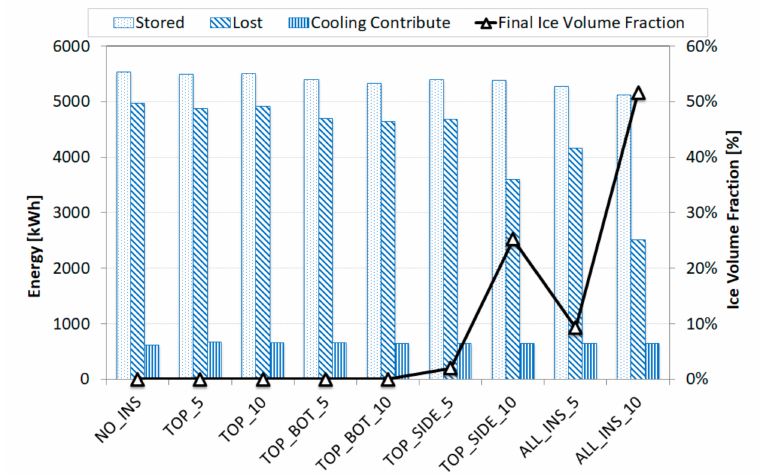
Figure 5. Energy analysis of the IT (second year of simulation).